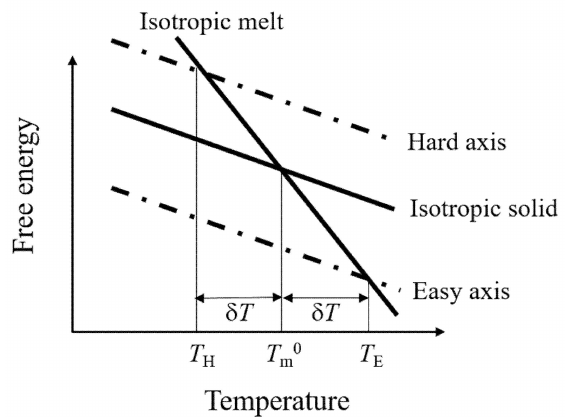
Figure 10. Temperature dependence of free energy. In anisotropic solids, free energy in a magnetic field di ff ers depending on the orientation direction, leading to the orientation dependent shifts of melting point.